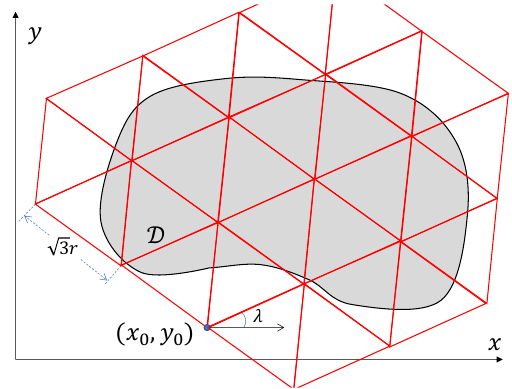
Figure 2. A triangulation T ( λ , x 0 , y 0 ) consisting of equilateral